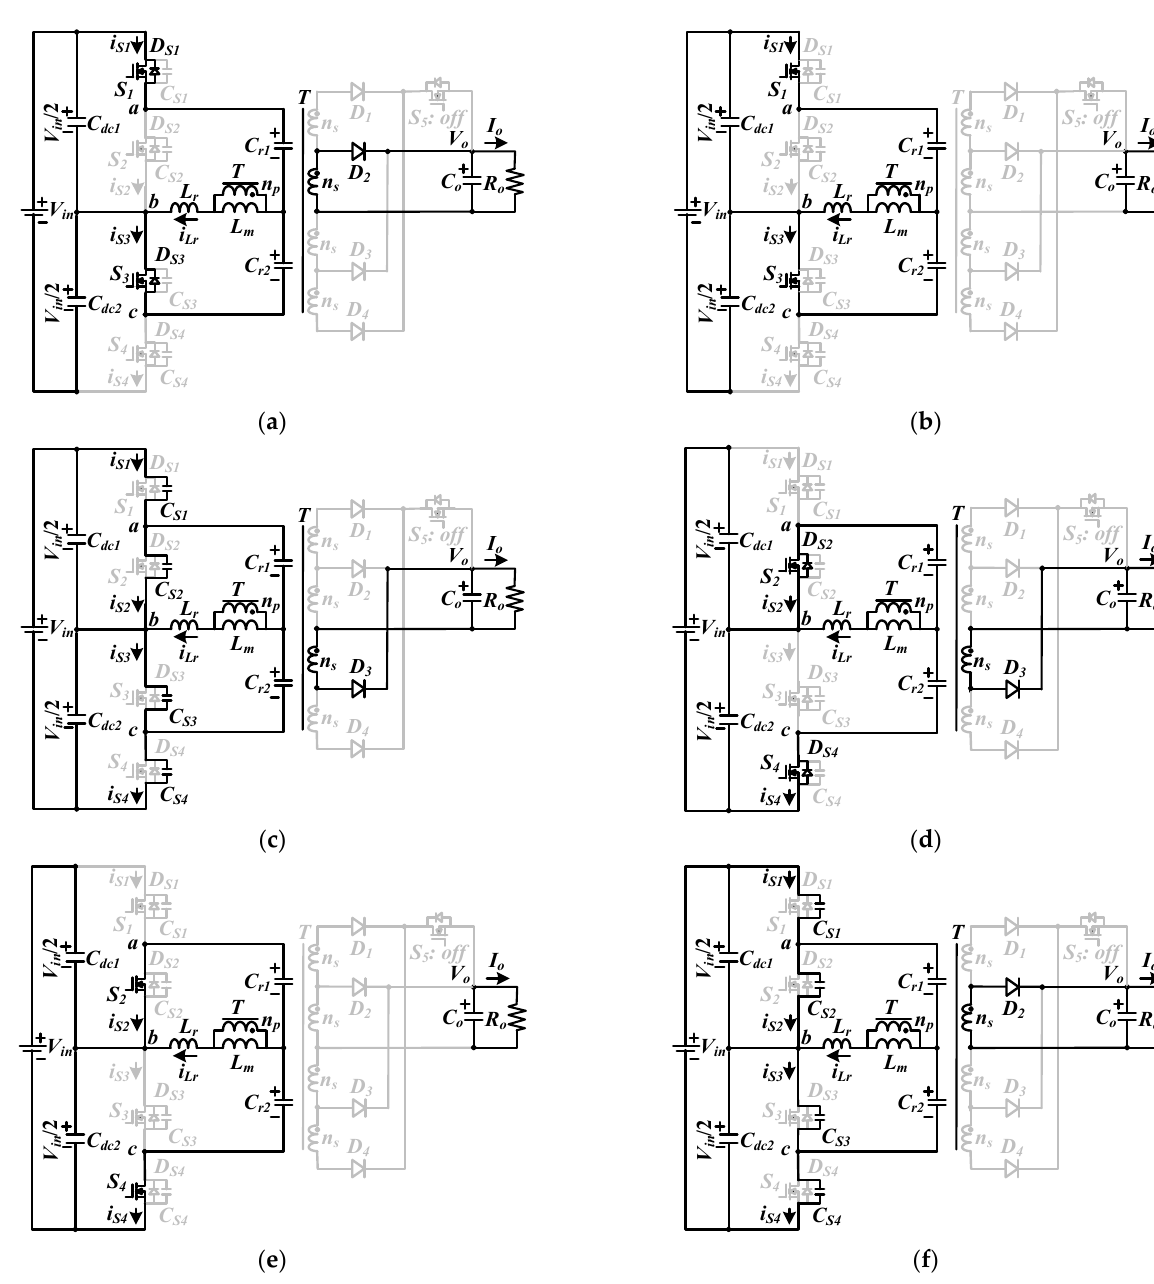
Figure 4. Equivalent mode circuits under low voltage range operation if f sw < f r : ( a ) mode 1 circuit, ( b ) mode 2 circuit, ( c ) mode 3 circuit, ( d ) mode 4 circuit, ( e ) mode 5 circuit, and ( f ) mode 6 circuit.